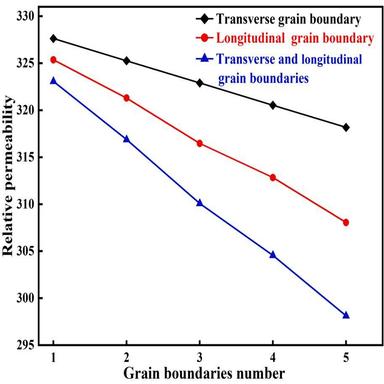
Relative permeability of the model with different grain size and grain boundary orientations.